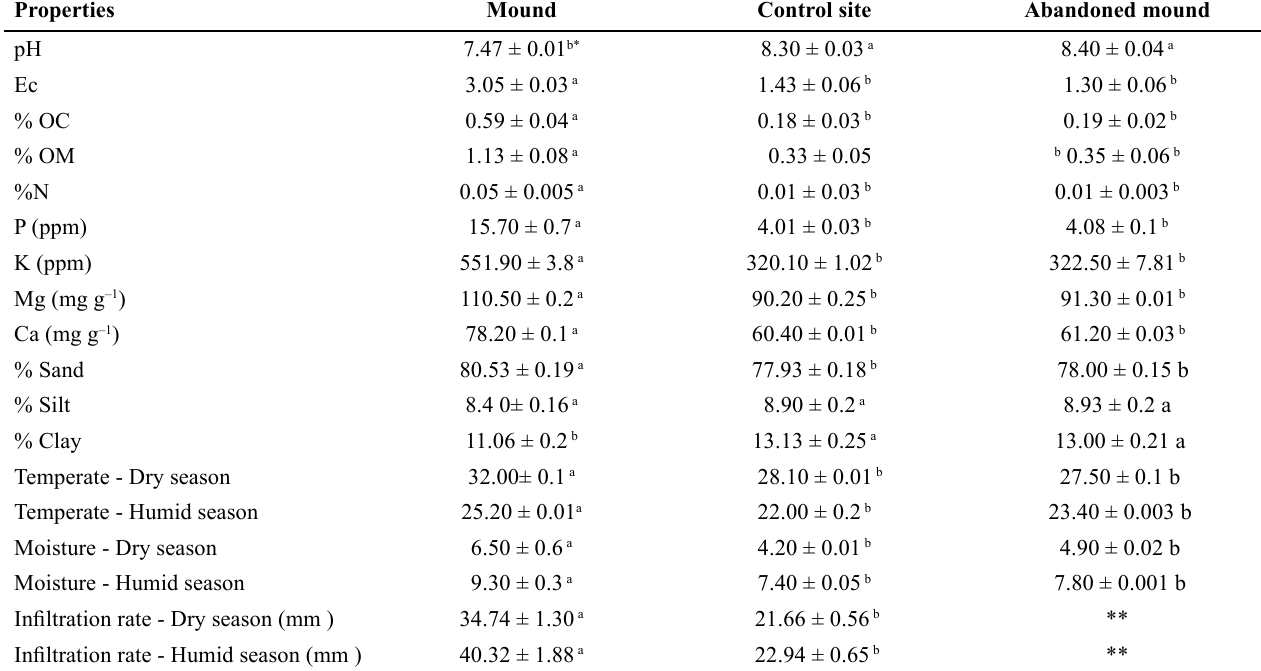
Table 2 . Line 1-16: Physical and chemical properties of soils (Mean from 0 to 40 cm) from Messor cf. intermedius mounds, dead mounds and control sites in the Roodshoor and significance of the comparison between sites by Duncan’s multiple range test (Mean±S.E; control and live nest each N=18, abandoned nest N= 7). Line 17-18: Results of soil infiltration measuring under conditions of high and low soil moisture